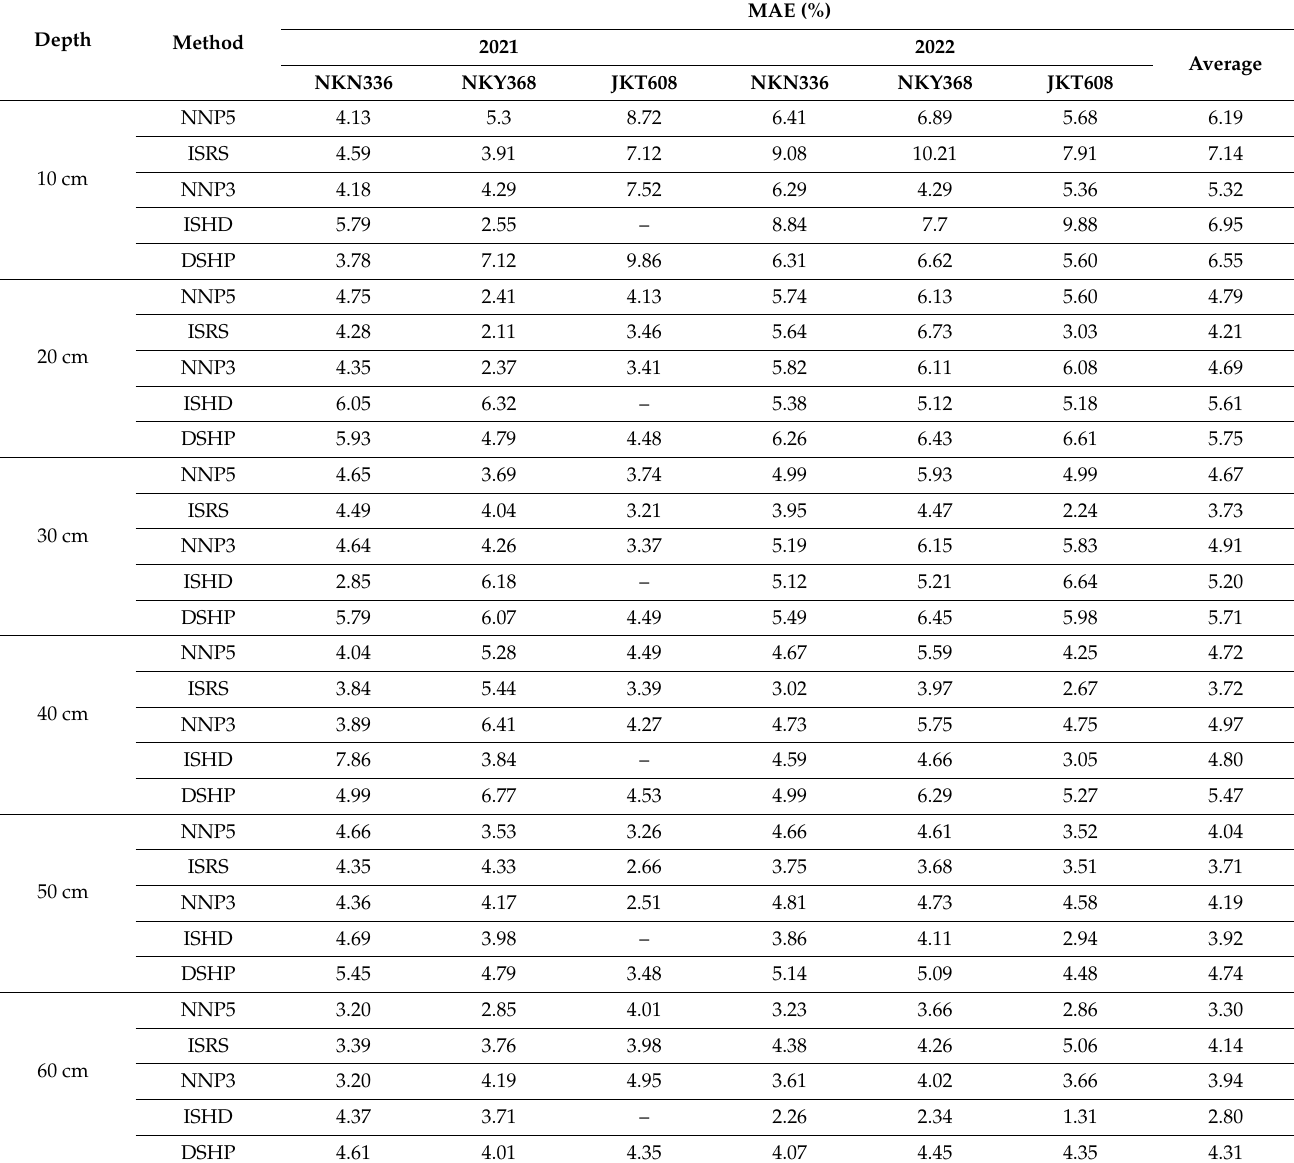
Table 10 lists the difference in the accuracy of the Hydrus-1D model for the SWC simulations at different soil depths. Among all the results, the ISRS approach at a depth of 10 cm had the largest MAE of 10.21% for the simulation of plot NKY368 with 2022 crops while the ISHD approach at a depth of 60 cm had the smallest MAE of 1.31% for the simulation of plot JKT608. Based on the average values of the simulation errors of each plot, the ISRS approach based on remote sensing data achieved the best simulation accuracy at depths of 20, 30, 40, and 50 cm; the average MAE was within 3.71–4.21%. However, the ISRS method performed poorly at a depth of 10 cm, with an average MAE of 7.14%, making it the parameter-acquisition method with the largest simulation error. The DSHP method based on default parameters performed the worst at all depths, except at a depth of 10 cm. The remaining parameter acquisition methods did not exhibit significant error-ranking characteristics. Table 10. Results of the SWC simulation errors for the Hydrus-1D model with different parameters, soil depths, and